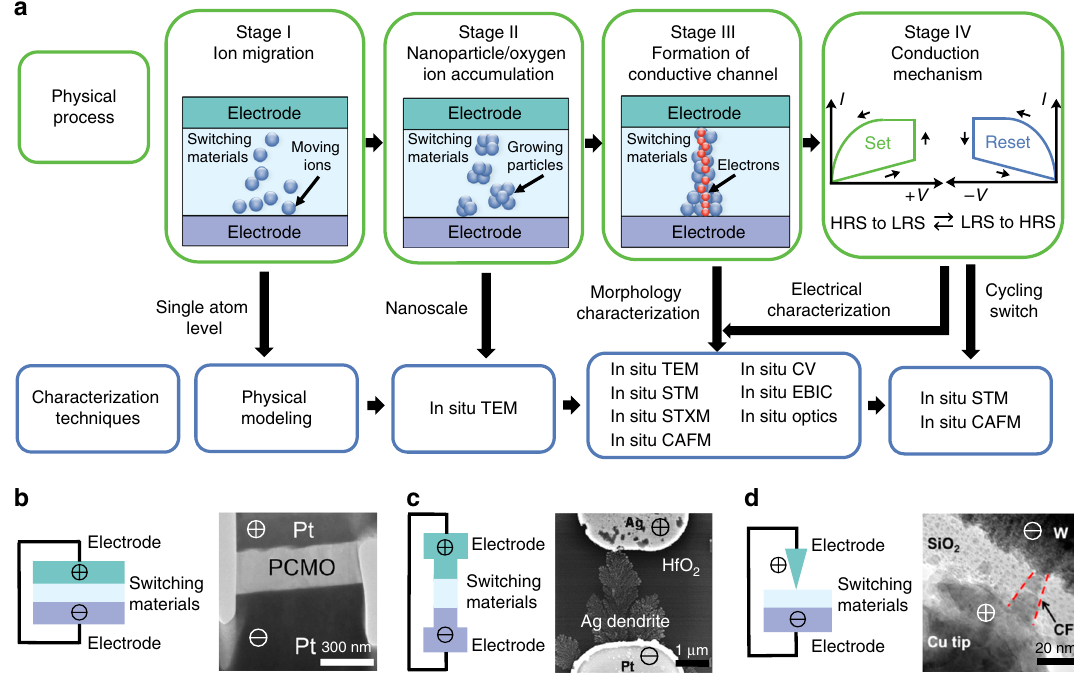
Fig. 3 Application of in situ techniques at different switching stages. a Technique for characterizing the different physical stages of resistive switching in a memristor. Green boxes are the physical processes for different stages starting from the initial ion migration to the resistive switching between the HRS and LRS. The schematic models for each stage are constructed according to the switching mechanisms of the cation devices, to demonstrate the spatiotemporal scale for each stage. Blue boxes are the corresponding characterization techniques for each physical stage. b Schematic and experimental examples of the vertical structure, c lateral structure, and d tip-based structure. Reproduced from ref. 43 , Elsevier B.V. ( b ); ref. 45 , AIP ( c ); and ref. 46